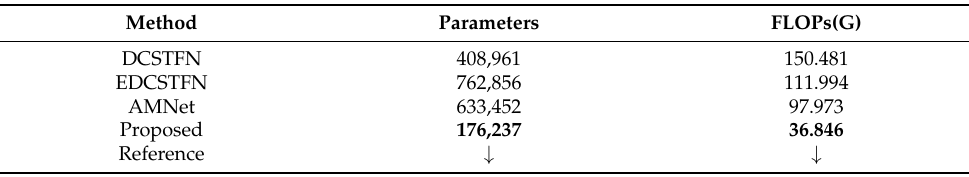
Table 5. Comparison of computational efficiency of each method.